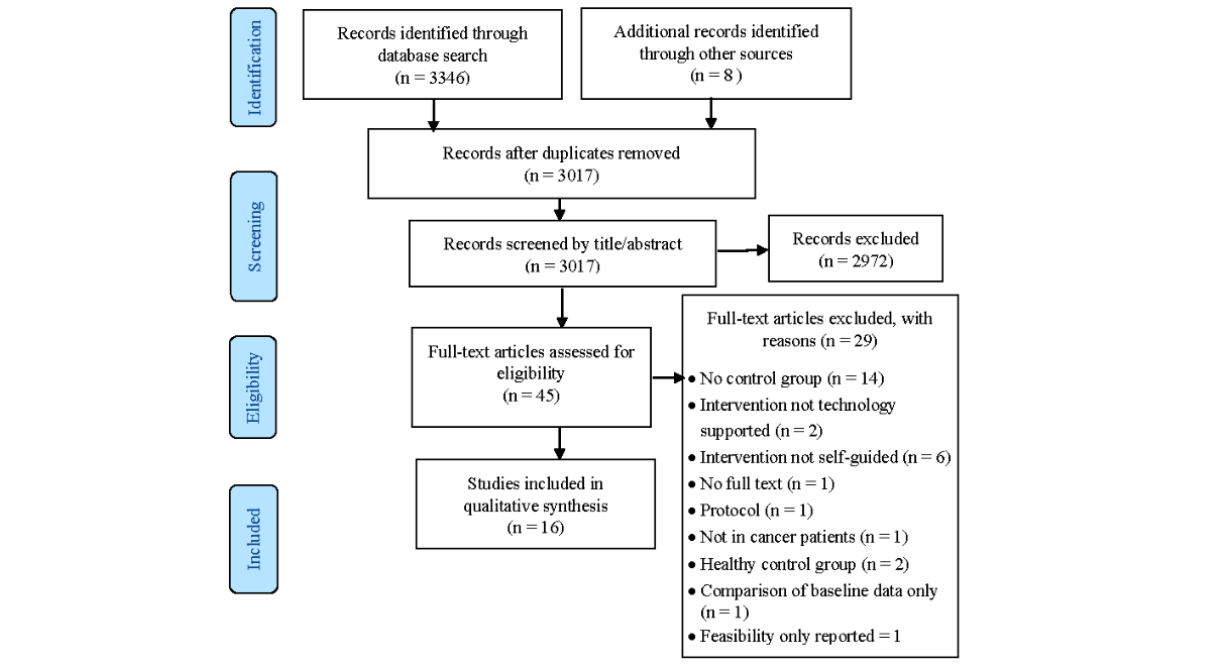
Figure 1. Selection